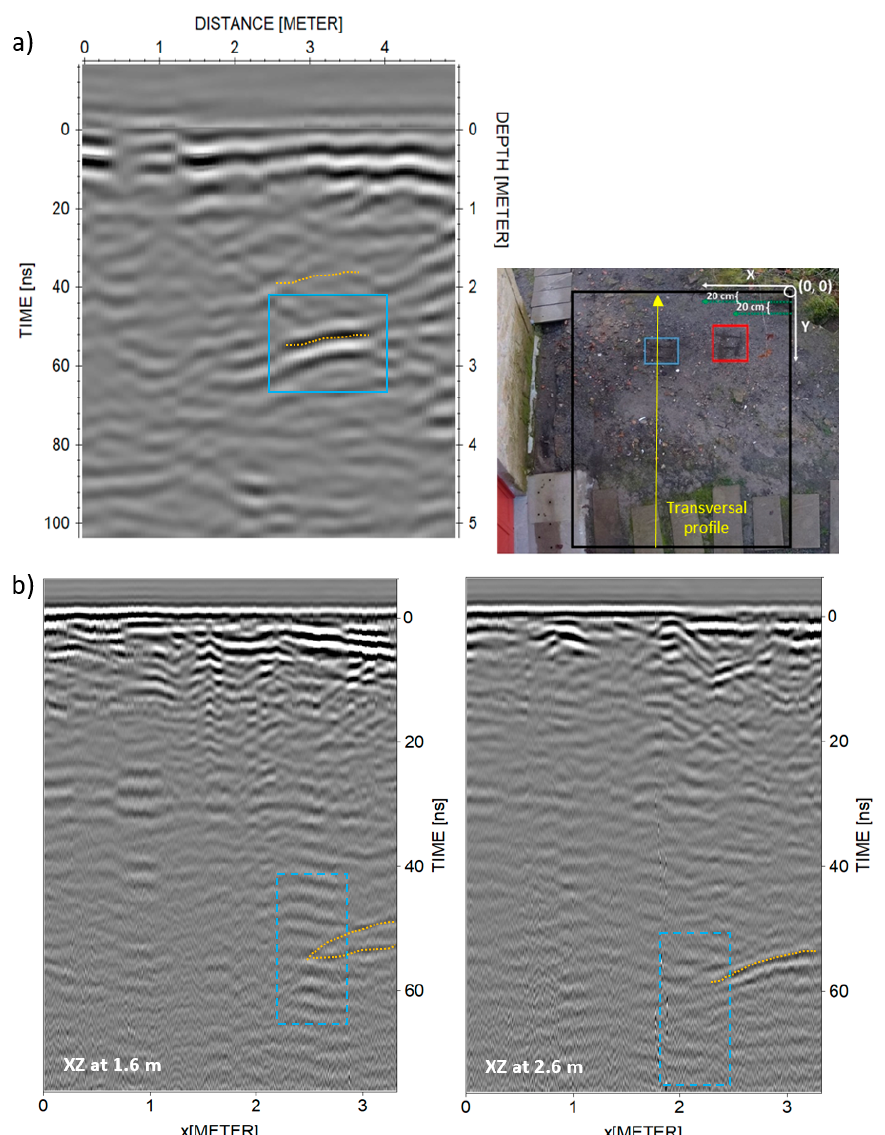
Figure 8. Additional 200 MHz transversal profile acquired along the probable fractured area ( a ), and 500 MHz XZ at 1.6 and 2.6 m in y -line ( b